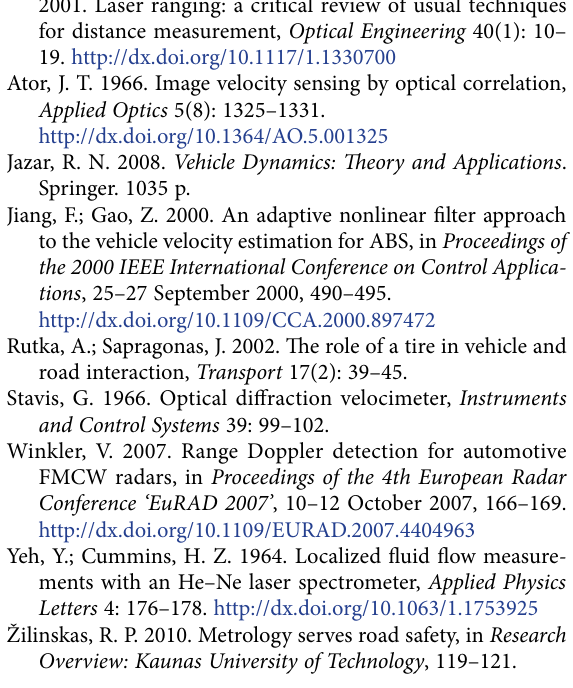
ABS measurement Laser measurement